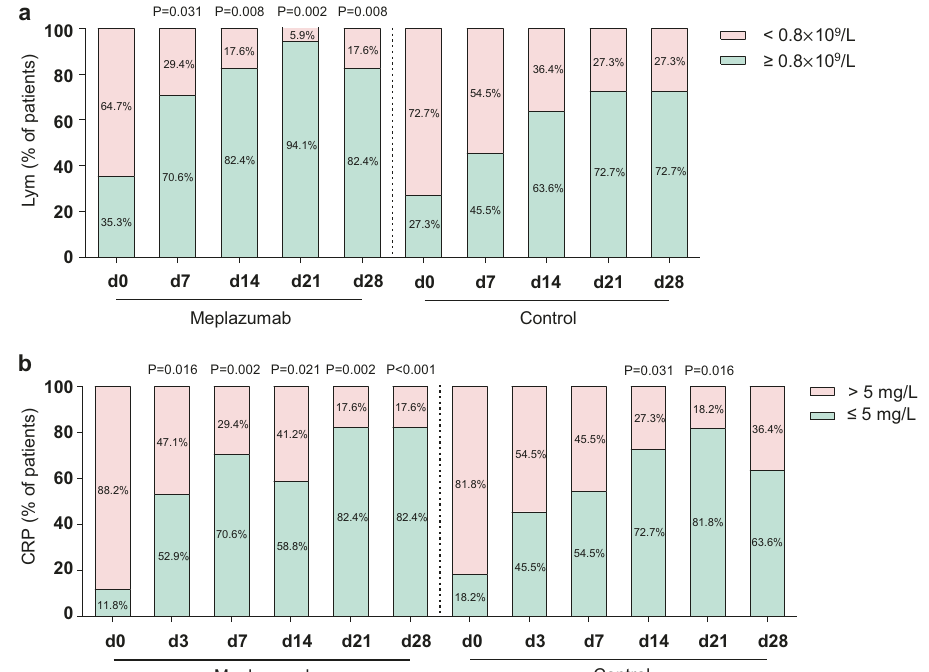
Fig. 5 The proportion of patients regarding lymphocyte count and CRP concentration. The proportion of patients (% patients) with or without normal lymphocyte count ( a ) and CRP concentration ( b ). The P value comparing between baseline (d0) and each time point was determined by McNemar ’ s test, shown on the top of the